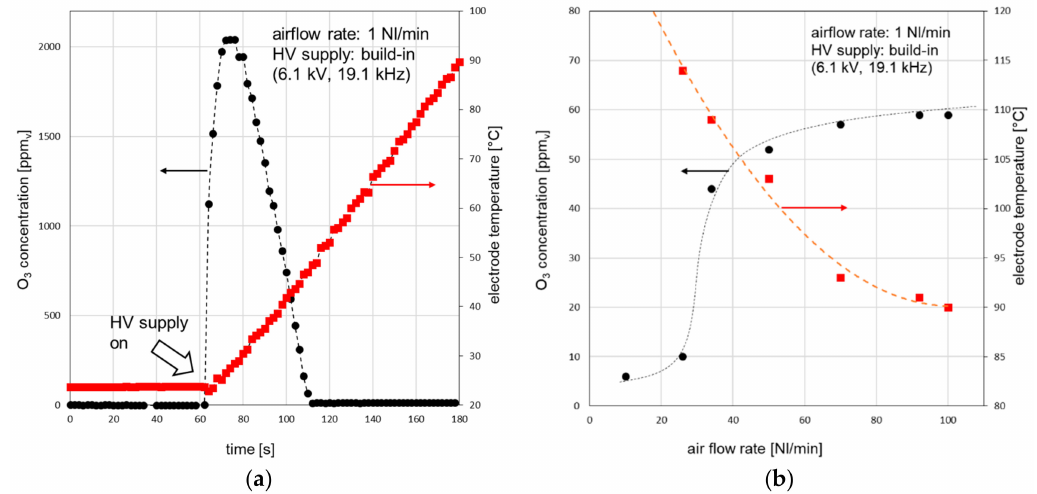
Figure 7. Variations of O 3 concentration and electrode temperature in surface DBD OG supplied